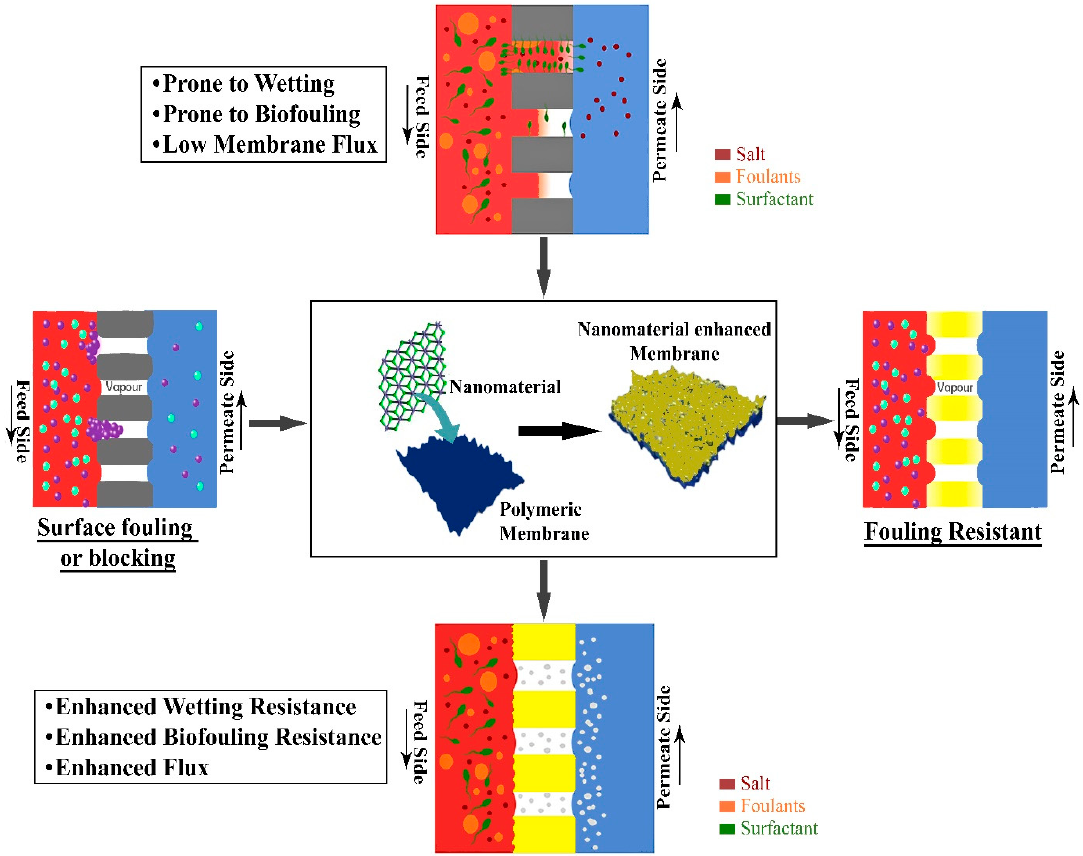
Figure 3. Effectiveness of nanomaterials on the MD membrane Figure 3. E ff ectiveness of nanomaterials on the MD